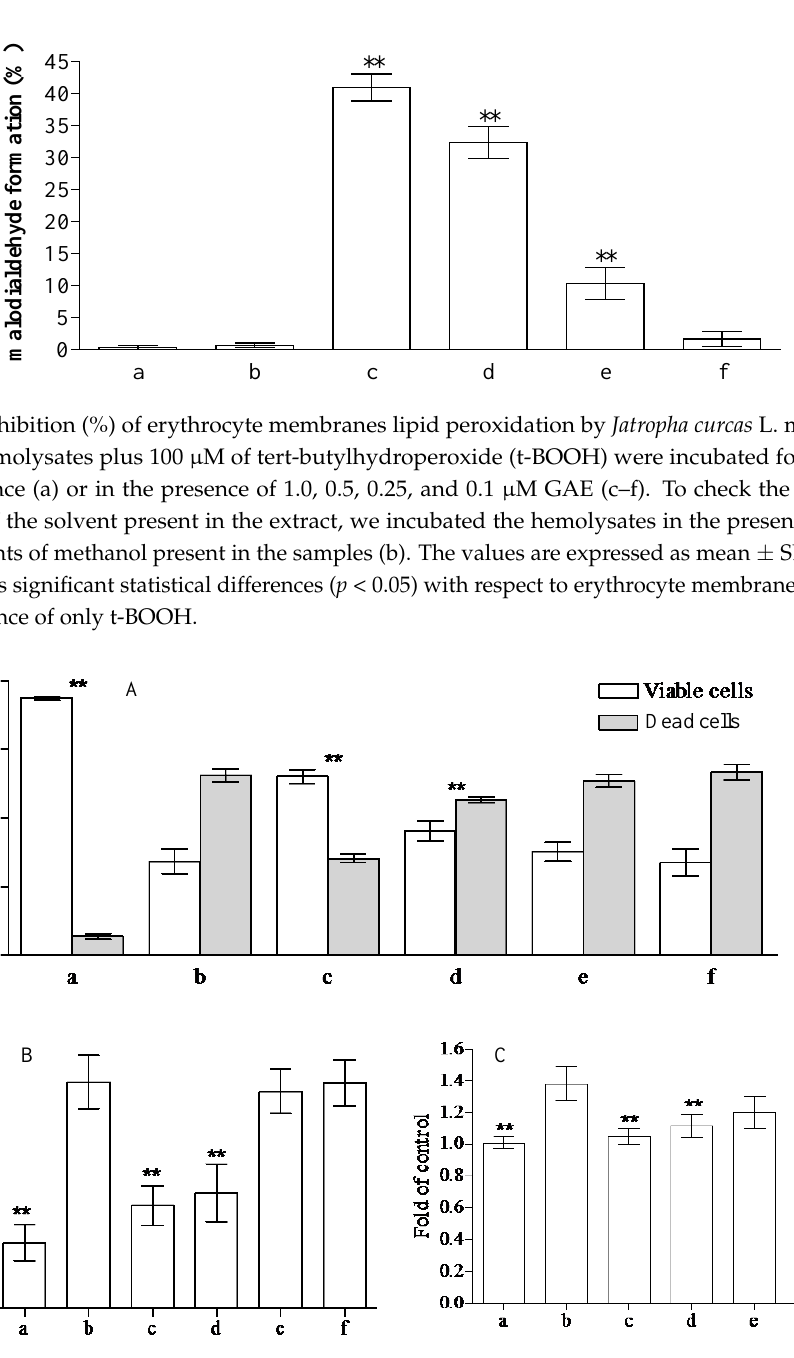
Figure 2. Cytoprotective effects of Jatropha curcas L. methanol extract on lymphocytes. Lymphocytes plus 100 µM of t-BOOH were incubated for 24 h in the absence (b) or in the presence of 1.0, 0.5, 0.25, and 0.1 µM GAE (c–f). To check the possible influence of the solvent present in the extract, we incubated the lymphocytes in the presence of the same amounts of methanol present in the samples (a). Cell vitality, integrity, and apoptotic events were analyzed by trypan blue staining ( A ); lactate dehydrogenase (LDH) release ( B ) and caspase 3 activation ( C ), respectively. The samples were analyzed by one-way ANOVA, followed by Tukey’s test. Asterisks ** indicate significant differences ( p < 0.05) with respect to lymphocytes treated in the presence of only t-BOOH. Each value represents mean ± SD ( n = 3).